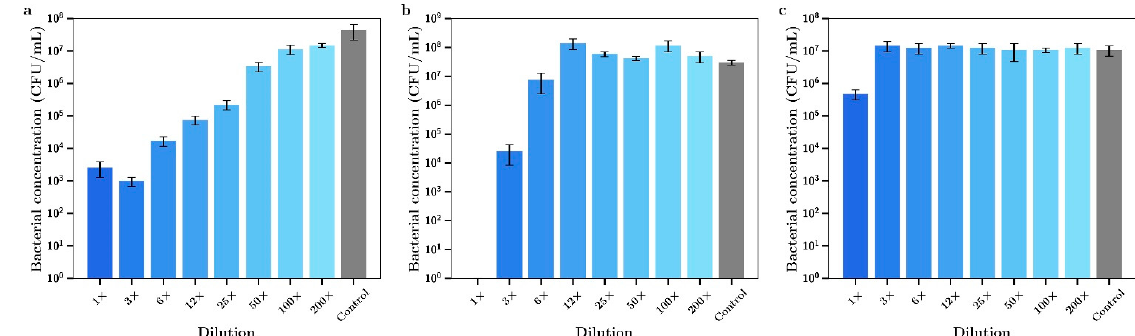
Figure 12. Bacterial concentrations of P. aeruginosa incubated in various dilutions of the 7-day incubation release media of bone cement containing ( a ) Ag, ( b ) Ag + tobramycin, ( c ) tobramycin. (Silver loaded at 0.8% and tobramycin at 0.8% w/w ) ( n = 3).